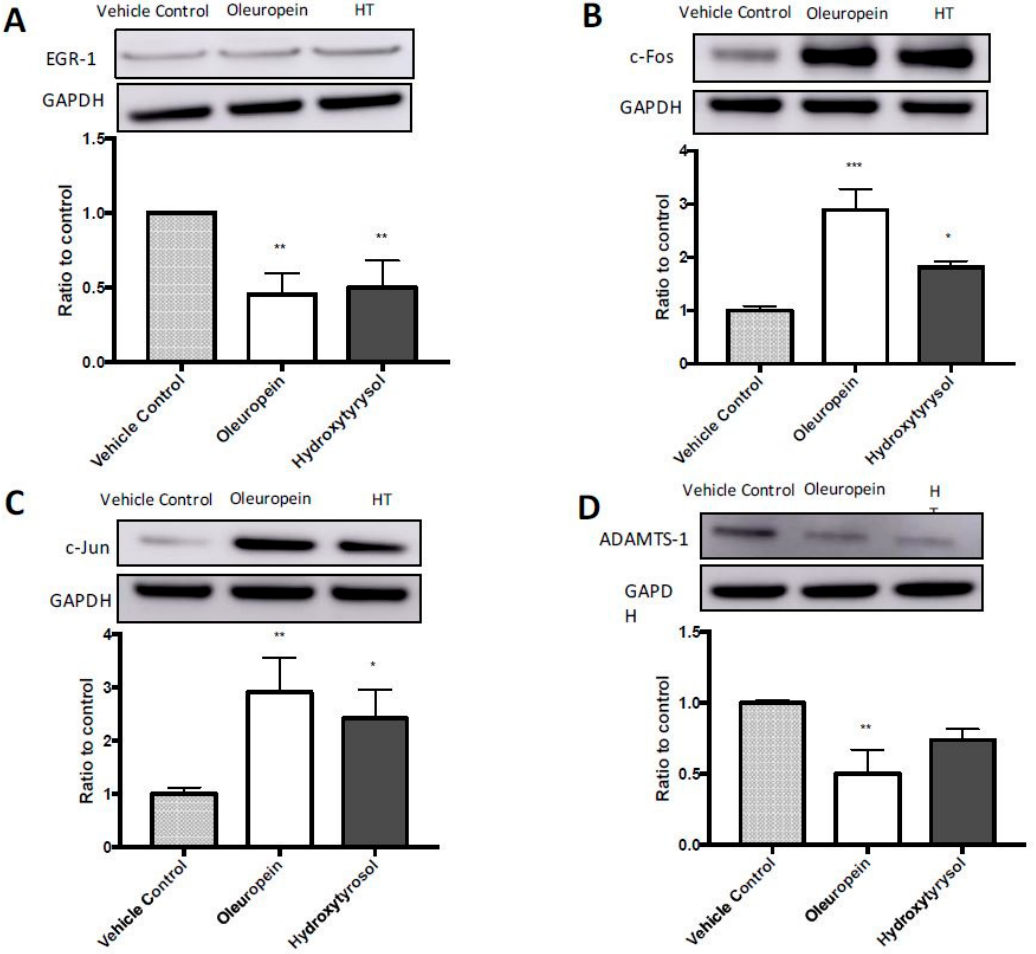
Figure 6. Protein expression of: EGR-1 ( A ); c-Fos ( B ); and c-Jun ( C ) in MIA PaCa-2 cells; and ADAMTS-1 in HPDE cells ( D ). GAPDH was used as a loading control. Results displayed as optical density measurements of target antibody/GAPDH/control average; hence, results are represented as fold change. Ordinary one-way ANOVA with Tukey’s multiple comparisons test compares the expression of protein from treated cells (oleuropein or hydroxytyrosol) to vehicle control. * p 0.05, ** p 0.01, *** p 0.001.